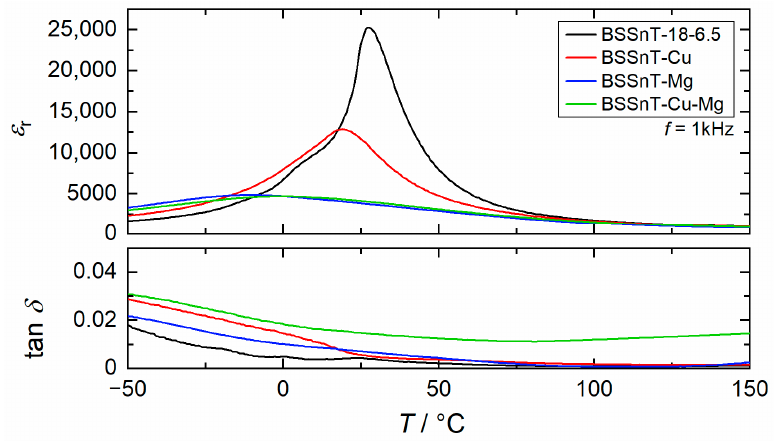
Figure 5. Temperature dependence of relative permittivity ( ε r ) and dielectric loss factor (tan δ ) measured at 1 kHz for BSSnT-18-6.5 ceramics with different additives.